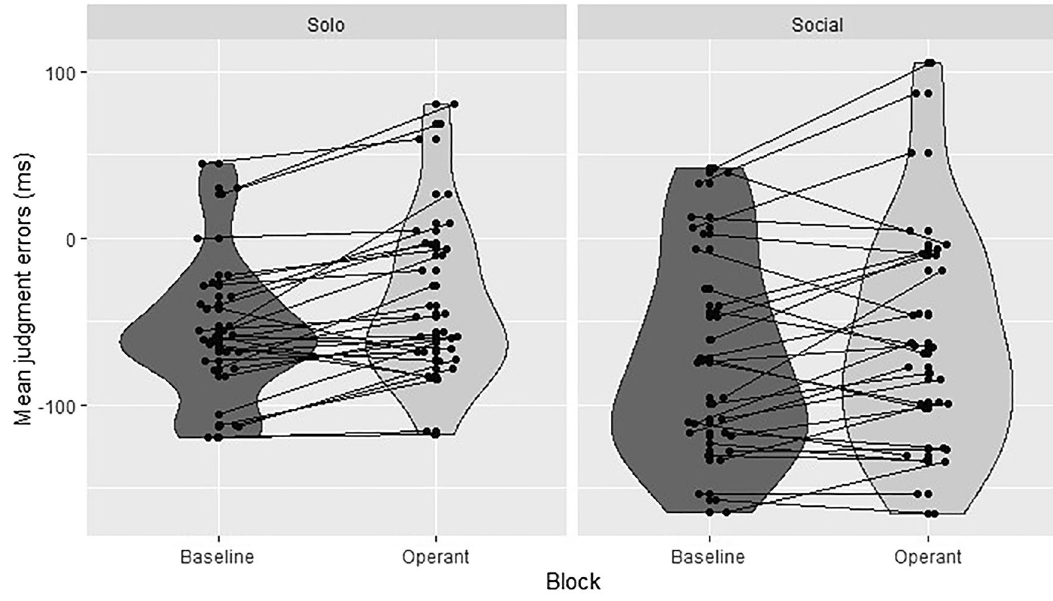
Figure 2. Mean JEs plotted as a function of Block (Baseline, Operant), separately for each Context (Solo, Social). Data points are plotted in pairs to illustrate the effects at the individual level.